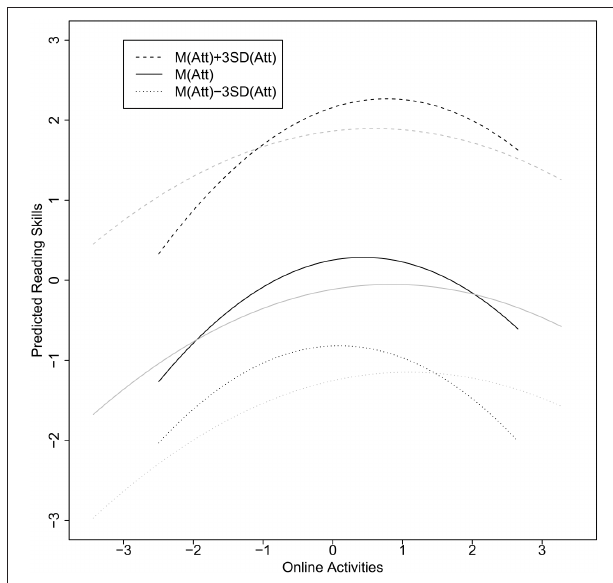
FIGURE 4 | Simple slopes for female (black lines) and male students (gray lines) based on a standardization using the pooled variances. The relationship for online activities and reading skills were estimated for low, average, and high reading